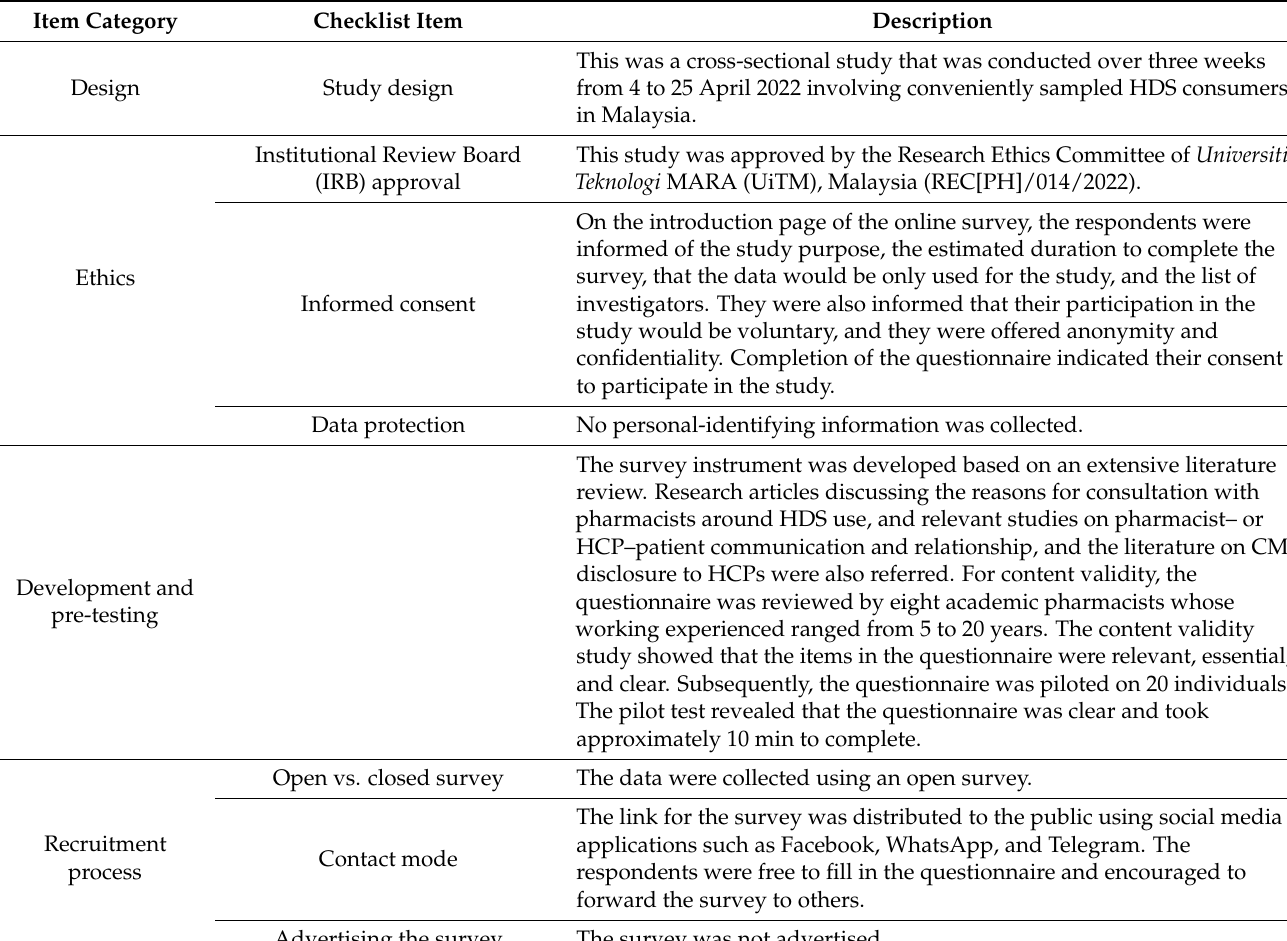
Table A1. Reporting of the study procedures and results according to the Checklist for Reporting Results of Internet E-Surveys